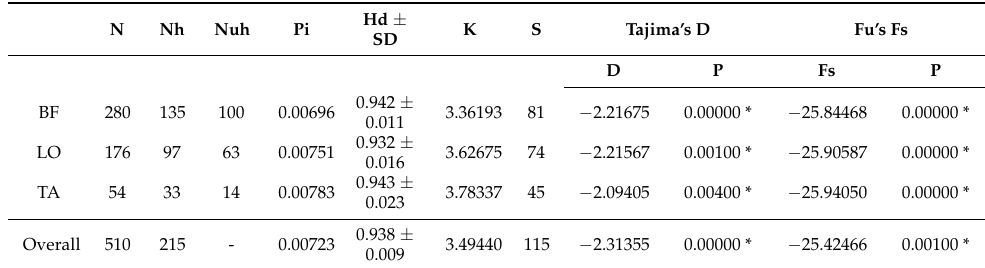
Table 5. Genetic diversity indices and neutrality test based on mtDNA cox2 sequences of A. simplex of European hakes from muscular sections: belly flaps (BF), loins (LO) and tails (TA). ± N Nh Nuh Pi Hd SD K S Tajima’s D